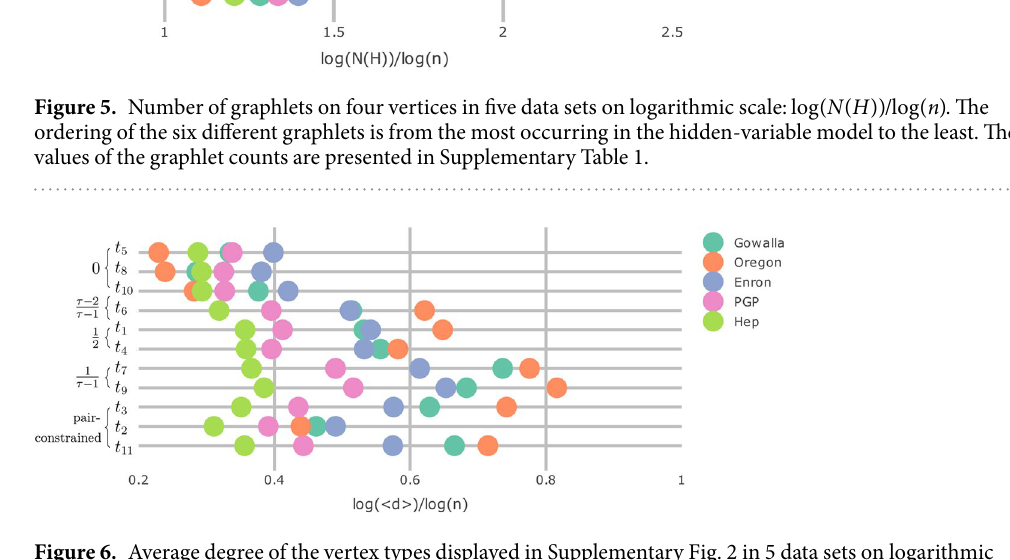
Figure 6. Average degree of the vertex types displayed in Supplementary Fig. 2 in 5 data sets on logarithmic scale. The curly brackets indicate the typical degree exponent of the vertex type in the hidden-variable